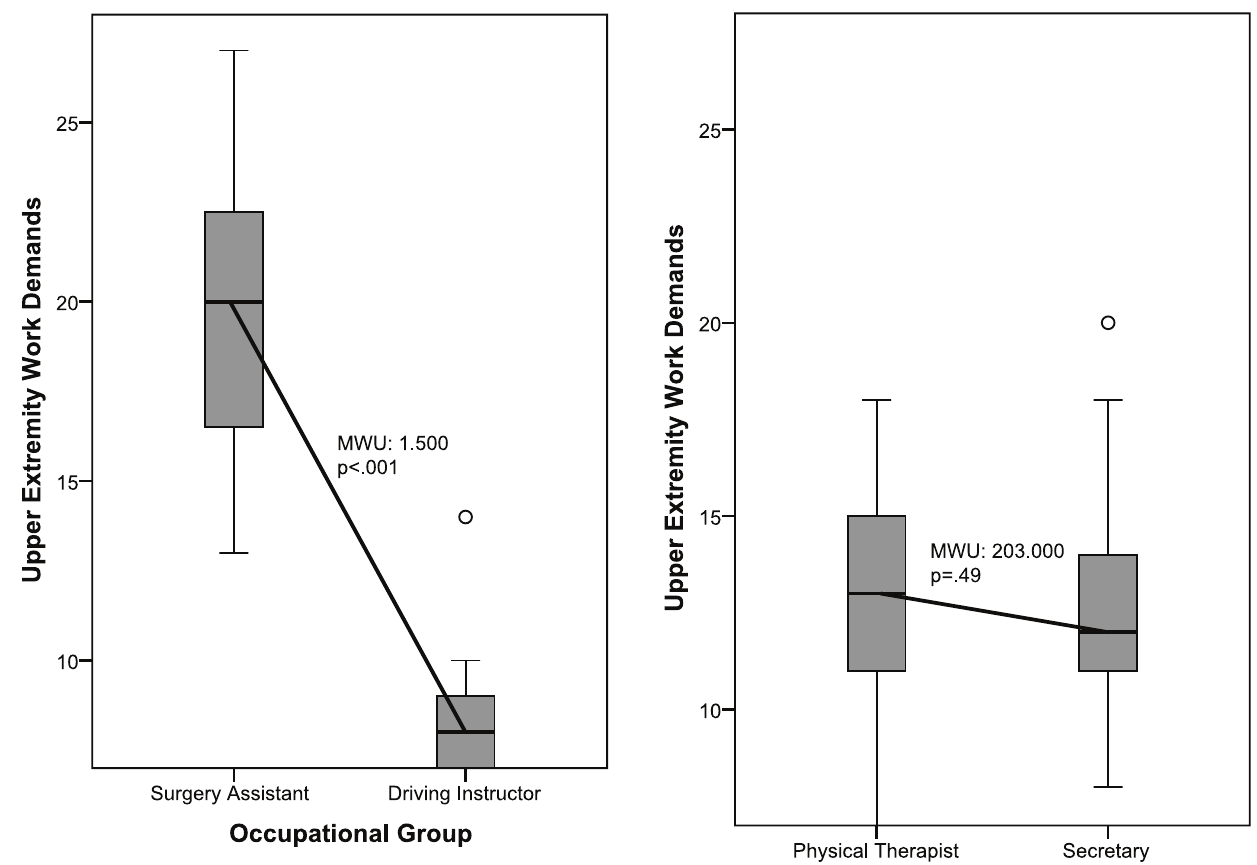
Figure 3. Upper Extremity Work Demands-scores within a DOT- category. MWU Mann Whitney U test; Scoring range of the Upper Extremity Work Demands: 7–28. doi:10.1371/journal.pone.0015158.g003 Figure 4. Upper Extremity Work Demands-scores between two